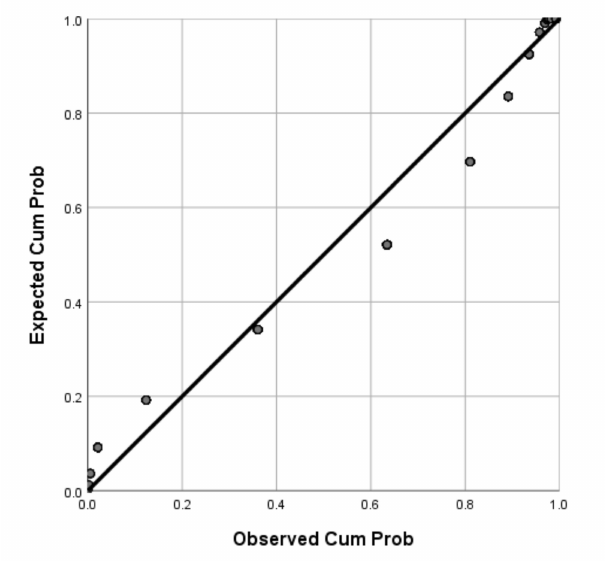
Figure 1. P-P plot of Age.